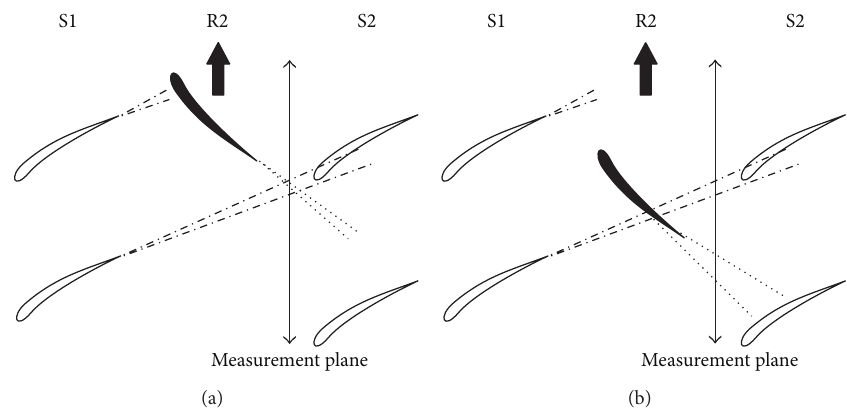
Figure 13: Cartoon showing S1 wake interactions with R2 and S2 representing configuration